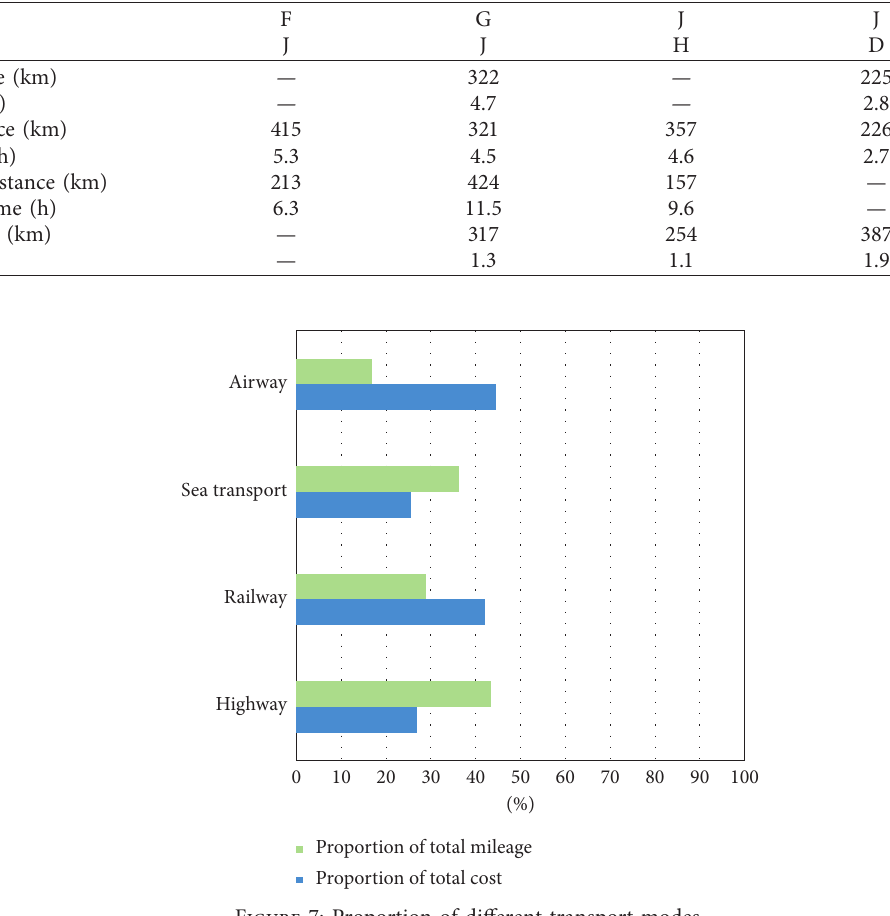
Table 4: Transport paths and time at node J.